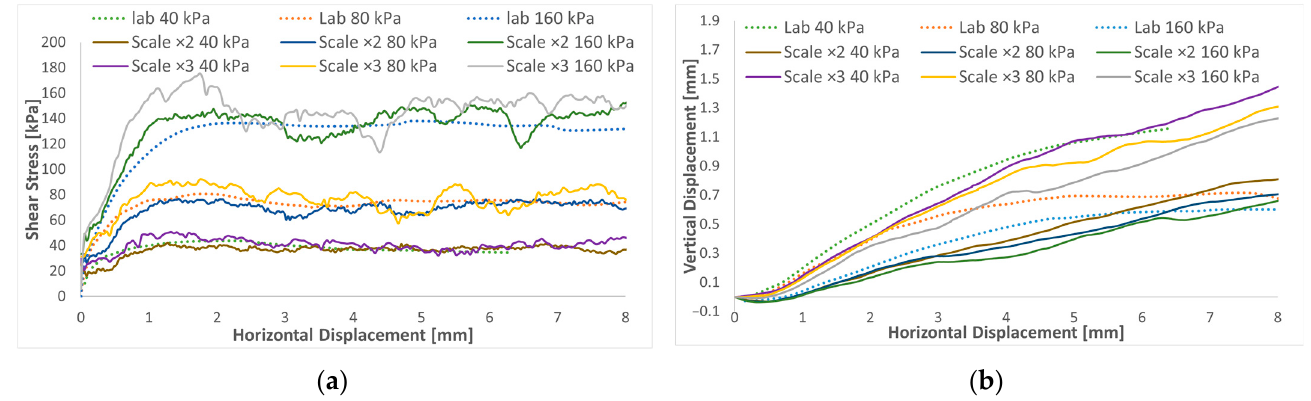
Figure 11. Shear stress and dilatation curves of up-scaled DST tests: ( a ) shear stress versus shear strain; ( b ) volumetric strain versus shear strain.